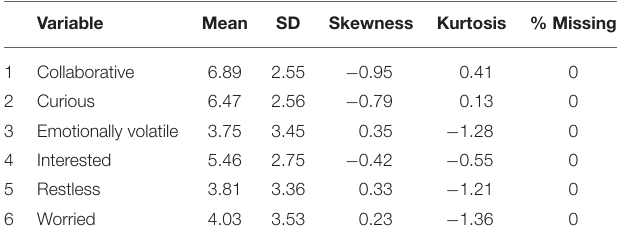
TABLE 3 | Descriptive statistics of observed students’ behaviors.